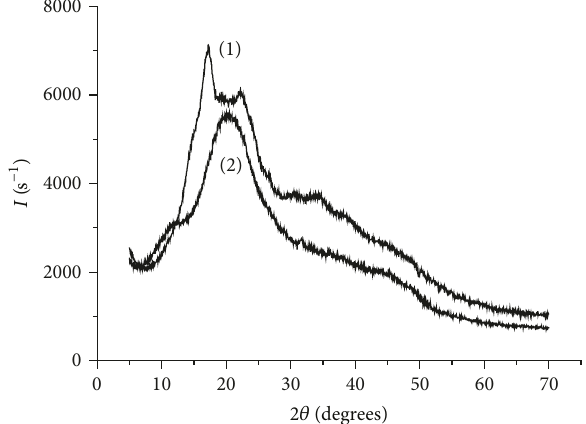
Figure 4: X-ray native (1) and modified (2) starches.